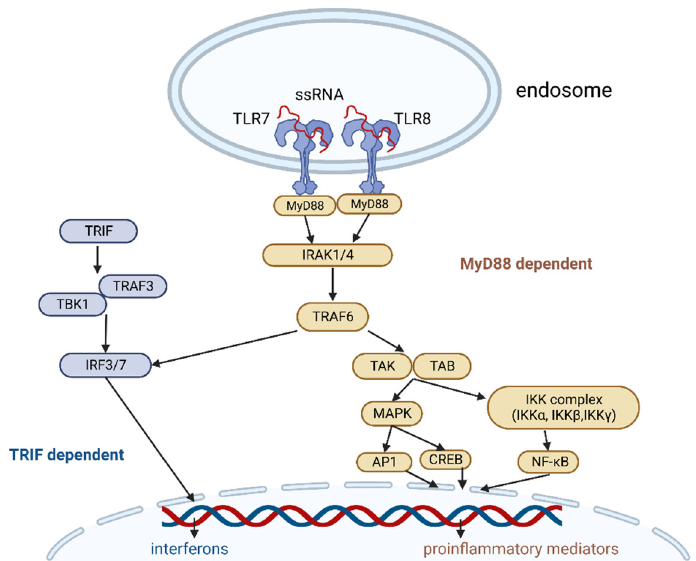
Figure 1. TLR7 and TLR8 signaling pathway. Image created with biorender.com (accessed on 19